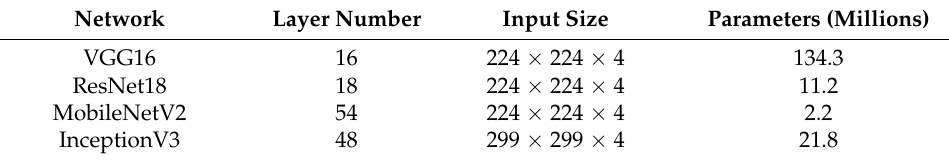
Table 4. Input size and number of model parameters.